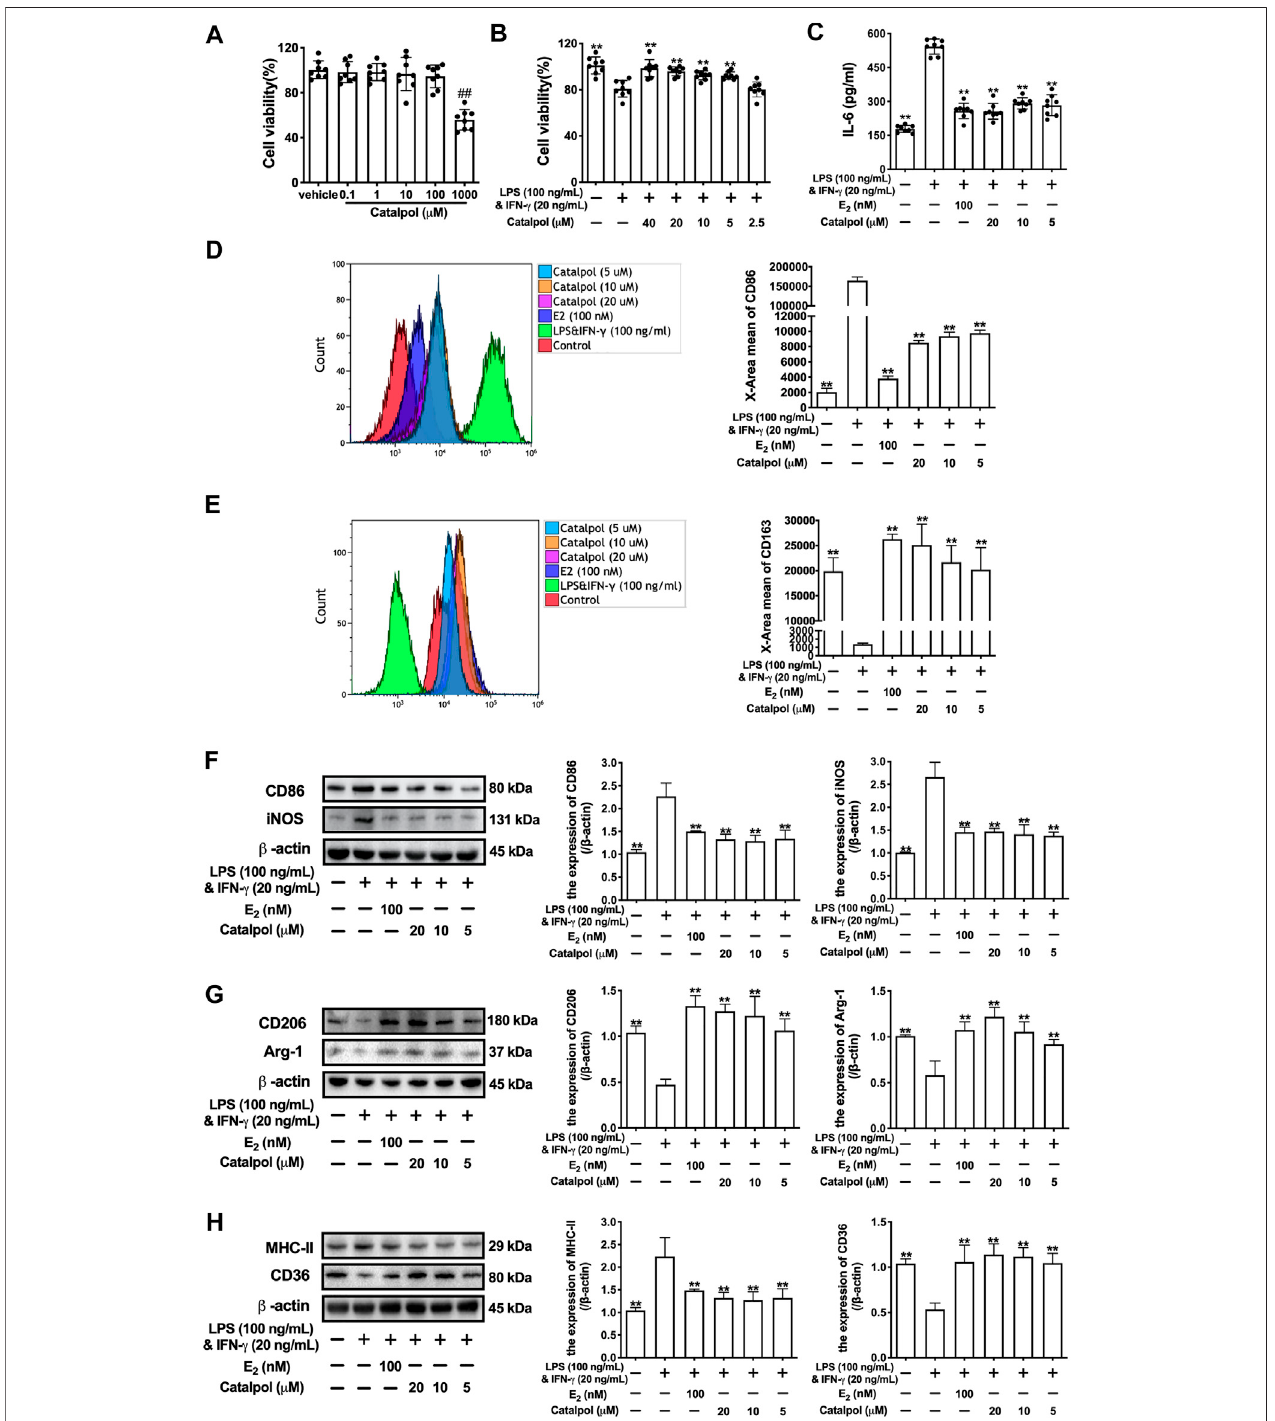
FIGURE1| CatalpolinhibitedM1macrophagepolarizationinducedbyLPSandINF- γ . (A) J774A-1weretreatedwithdifferentconcentrationsofcatalpol( n (cid:2) 8); (B) Effects of catalpol on M1 macrophage induced by LPS (100 ng/ml) and INF- γ (20 ng/ml) ( n (cid:2) 8); (C) Effects of catalpol on the level of IL-6 ( n (cid:2) 8); (D) The level of M1- macrophage marker CD86 was analyzed by FACS ( n (cid:2) 3); (E) The level of M2-macrophage marker CD163 was analyzed by FACS ( n (cid:2) 3); (F) Effects of catalpol on the expressionsofM1macrophagemarkers(CD86andiNOS)( n (cid:2) 3); (G) EffectsofcatalpolontheexpressionsofM2macrophagemarkers(CD206andArg-1)( n (cid:2) 3); (H) EffectsofcatalpolontheexpressionsofMHC-IIandCD36( n (cid:2) 3).Dataareexpressedasmean ± SD.# p < 0.05,## p < 0.01vs.vehiclegroup;* p < 0.05,** p < 0.01vs. LPS&INF- γ group.